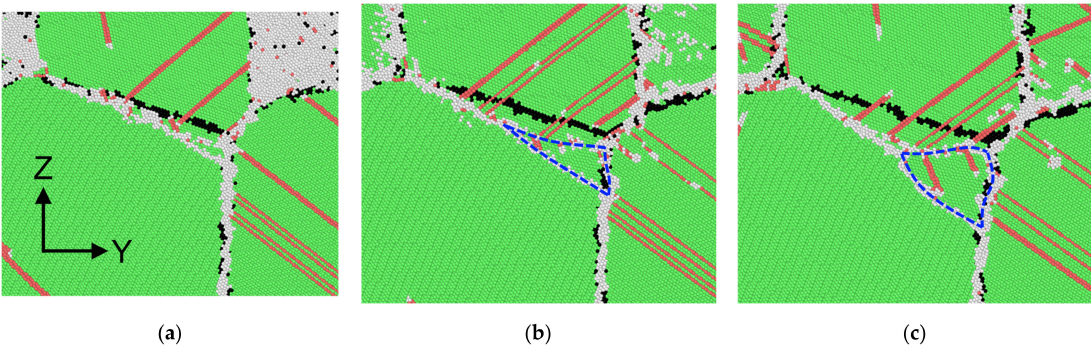
Figure 7. GB migration between a large and a medium grain. A cross-section fragment of the sample at X = 10 nm for strains: ( a ) 5.3, ( b ) 10.0, and ( c ) 15.0%. Atoms with fcc, hcp, and uncertain nearest neighbor symmetry are colored green, red, and gray, respectively. GB atoms at 0% strain are shown in